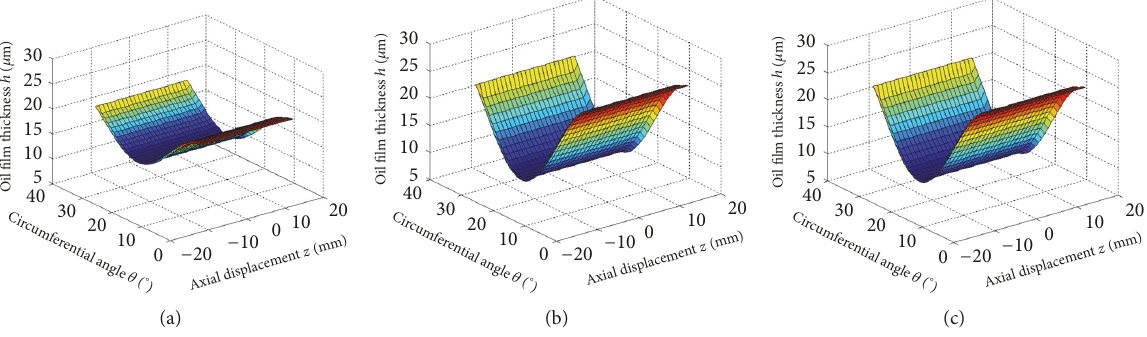
Figure 7: Film thickness of sliding bearing II under torque load. (a) 7.2 Nm, (b) 42.4 Nm, and (c) 81.5 Nm.